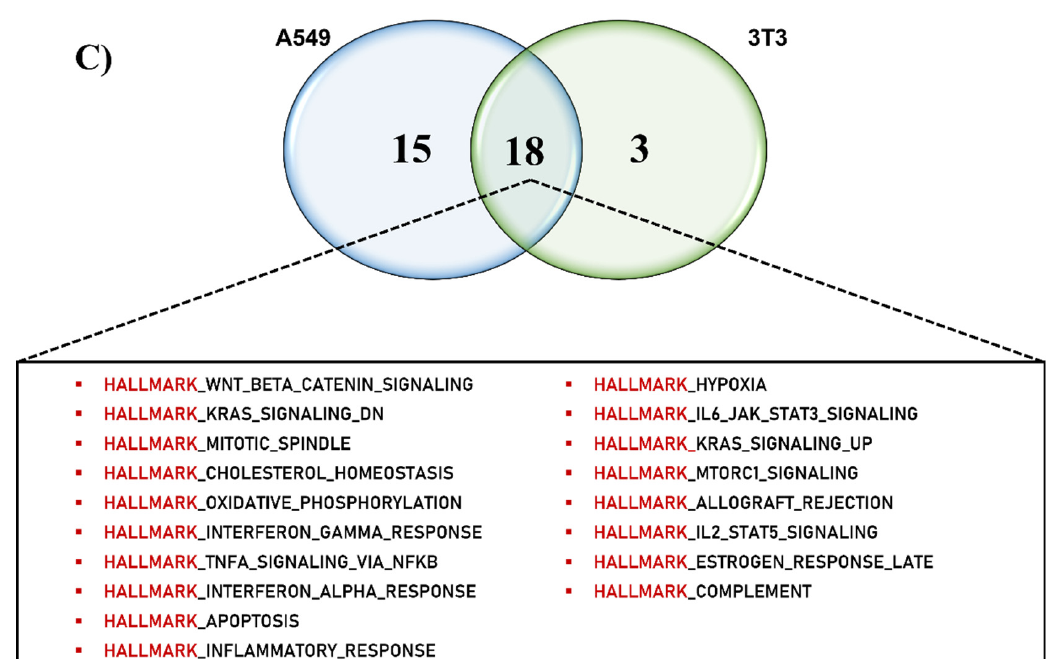
Figure 1. Pathway analysis of Transcriptional effect of SSRE extract. ( A ) Cytotoxicity assay of Sarcopoterium spinosum L. with different cell lines. A20 mouse lymphoma (black), HL-60 human promyelocytic leukemia (blue), NB4 cells (green), and A549 human lung cancer cells (red) were incubated with a range of concentrations of SSRE for 24 h, and an XTT assay was performed. ( B ) Comparative Gene Set Enrichment Analysis (GSEA) of extract effect on lung (A549) and Mouse Adipocyte (3T3) cell lines. In the middle, the number of common pathways that have been found in both cell lines after extract treatment has been described. ( C ) RNAseq-based protein-protein interaction networks of hub genes obtained from the STRING Database (interaction score > 0.9). (Isolated protein nodes were not depicted in Figure). The Intensity of nodes between genes represents the strength of the nodes and the interaction between